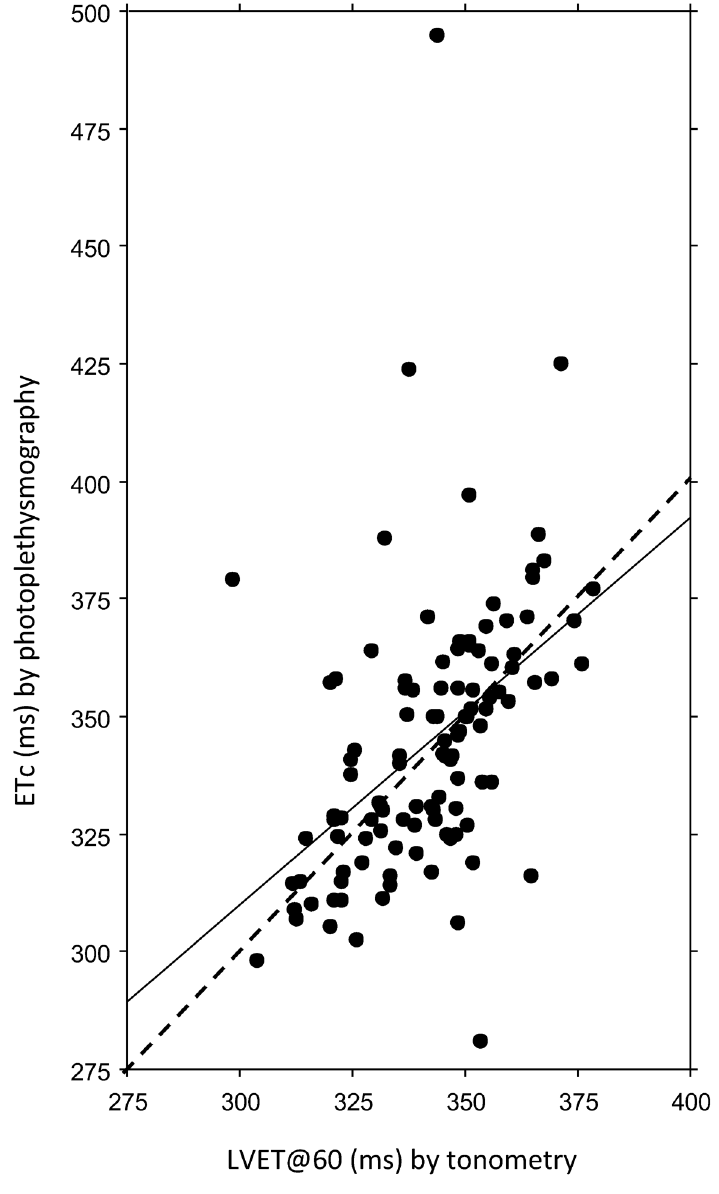
Fig 3. Association between ETc and LVET@60. Simple linear regression analysis of ejection time compensated (ETc) measured by photoplethysmography, and left ventricular ejection time adjusted to a heart rate of 60 bpm (LVET@60) measured by tonometry (r 0.46). The solid line represents the regression line and the interrupted line the line of